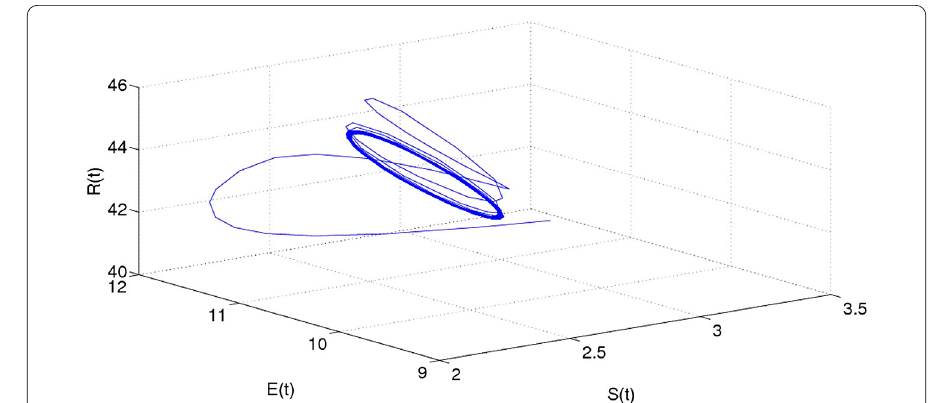
Figure 2 Dynamic behavior of system (63): projection on S-E-R with τ = 5.375.